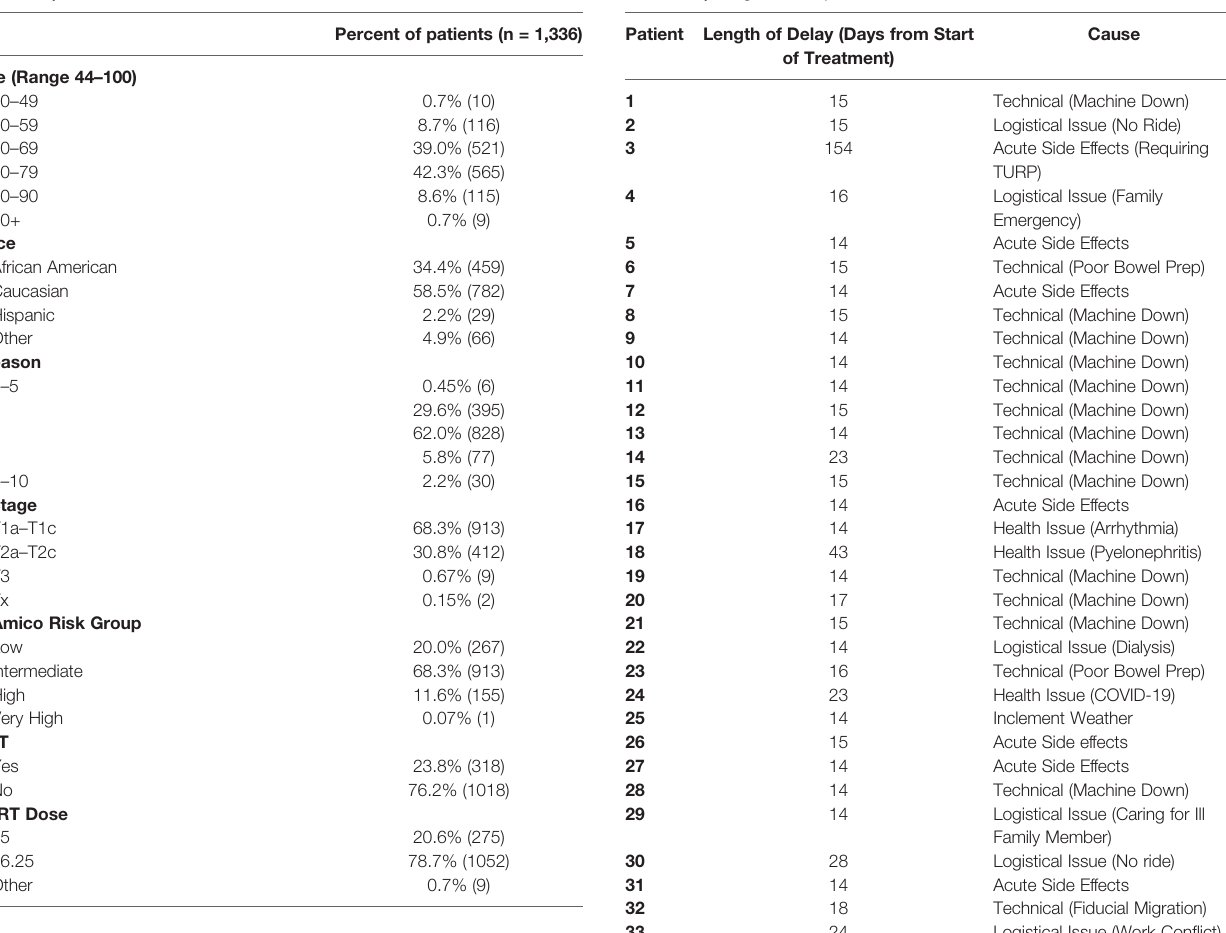
TABLE 1 | Patient characteristics.